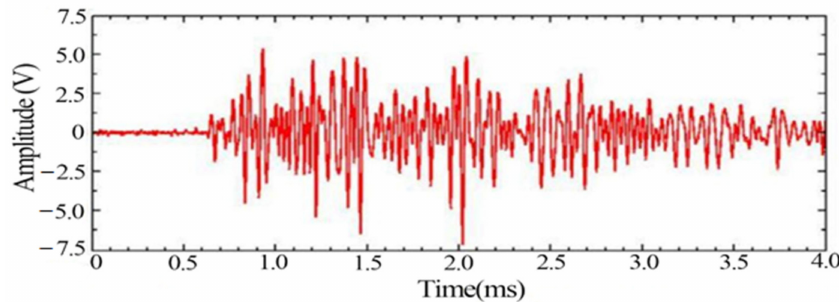
Figure 9. Signal waveform at the moment of fracture.